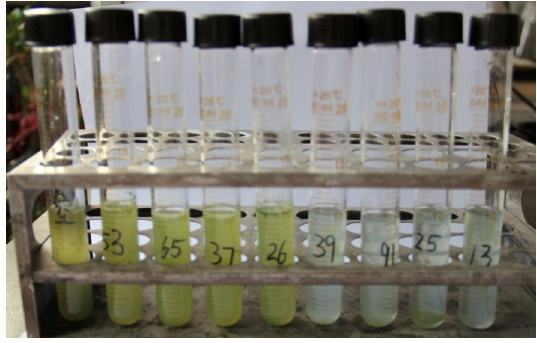
Figure 1. Algicidal effects of algicidal bacteria against Microcystis aeruginosa.